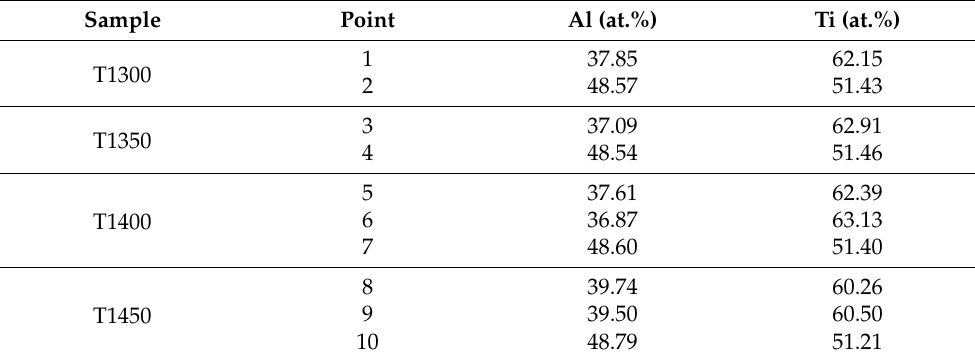
Table 3. Chemical composition of different regions marked in Figure 6 obtained by EDS analysis. Sample Point Al (at.%) Ti (at.%)